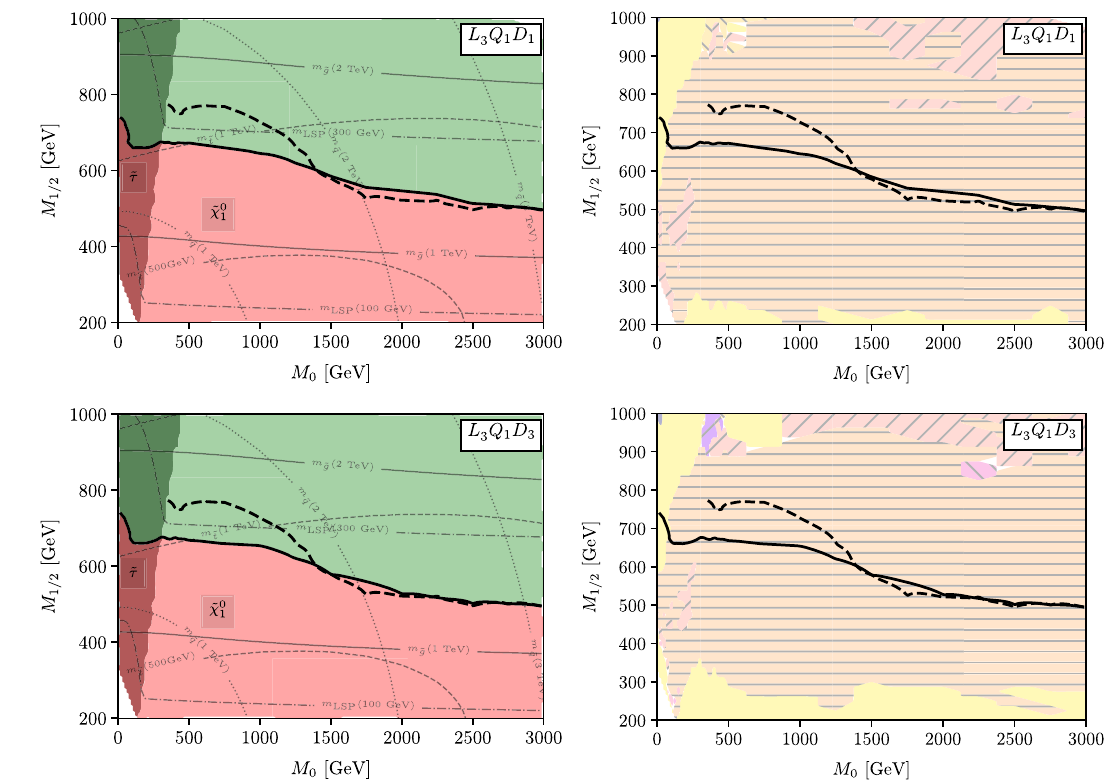
Fig. 15 Same as for Fig. 12, but considering the non-zero operators (in descending order) λ (cid:4)